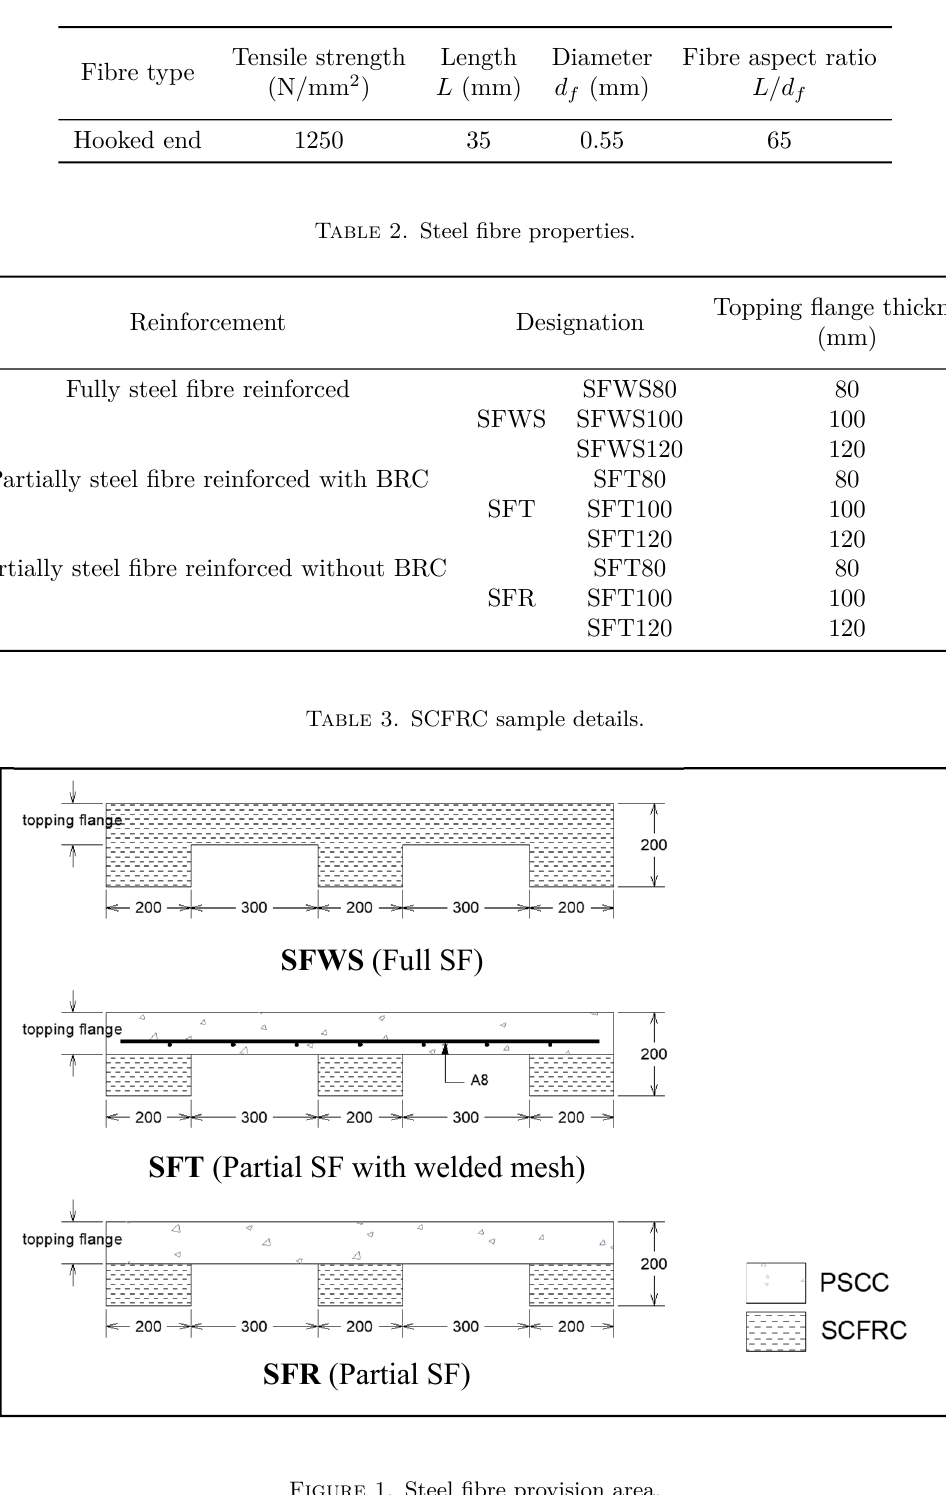
Figure 1. Steel fibre provision